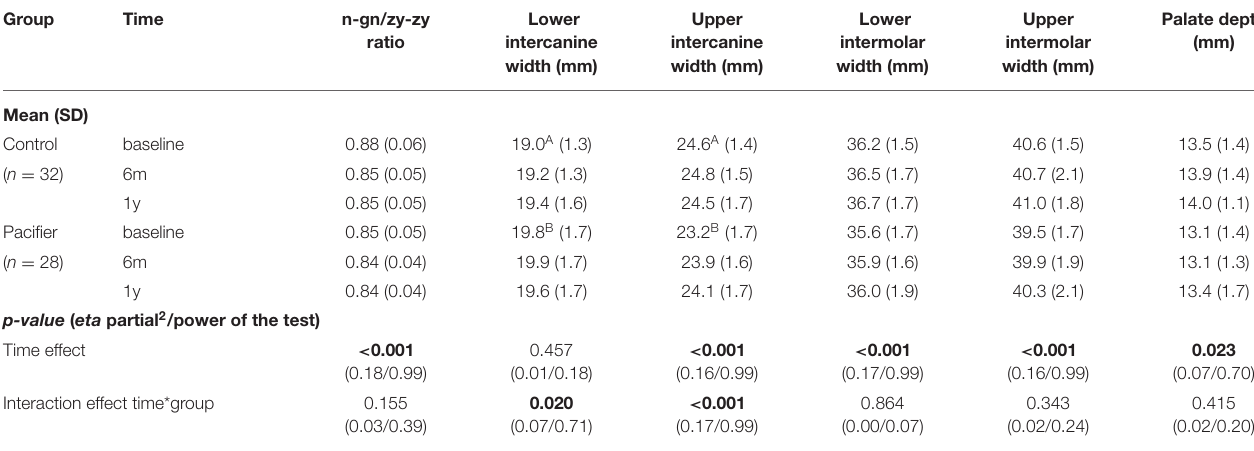
TABLE 2 | Interaction effect time*group on orofacial morphological aspects: a Two-way Mixed Model. Group